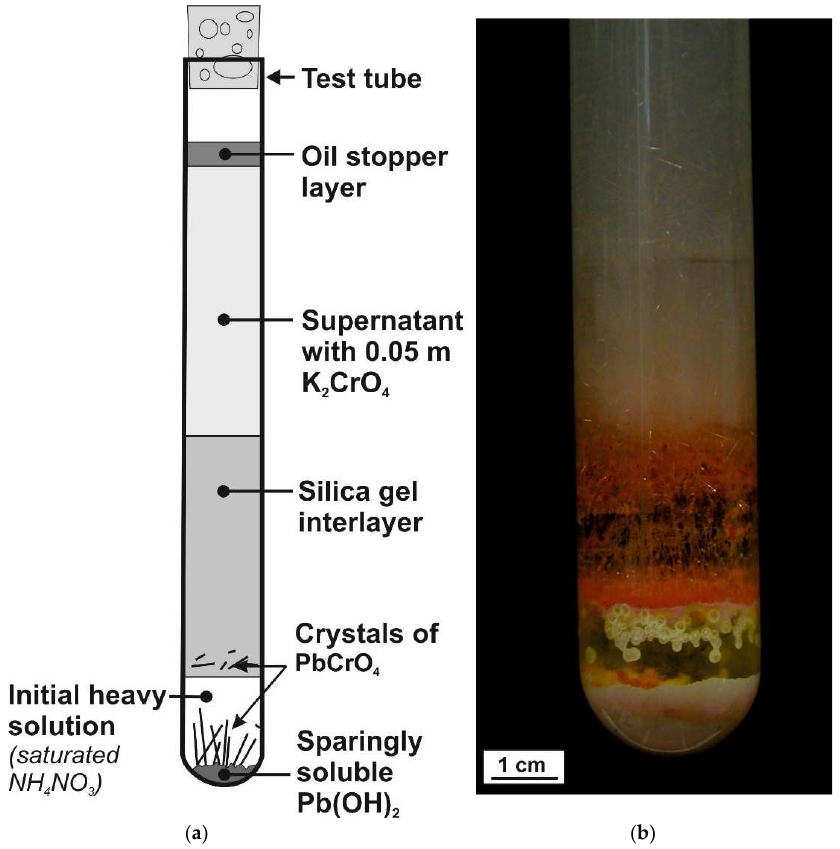
Figure 16. Hybrid gel setup to obtain PbCrO 4 (krokoite) crystals. ( a ) Schematic representation of the experiment; ( b ) Detail of the reaction alcove with the orange PbCrO 4 product. Note the white layer of the insoluble Pb(OH) 2 reagent on the bottom of the test tube. The scheme adopted above can be used for the synthesis of many other types of minerals including hydrous REE-phosphates, such as churchite-(Y), YPO 4 ∙2H 2 O, or the former and synthetically obtained hydroxylapatite, Ca 5 (PO 4 ) 3 (OH) for the latter in powdered form, acting as the respective sparingly soluble reagents. The reaction alcove was again formed directly above the powders using NH 4 NO 3 . After the placement of an HNO 3 -acidified 0.3 m Na 2 SiO 3 gelling solution and ageing of the obtained gel in both examples, a 0.3 m NaPO 3 solution was administered in the former and a 0.3 m CeCl 3 solution in the latter case. In approximately five months, beautiful multifaceted churchite- (Y) single crystals formed in the former case (Figure 17a). As for the rhabdophane setup, the whole of the synthetic hydroxylapatite reagent was converted to the respective title compound, albeit with the crystals having a somewhat fibrous form (Figure 17c). The successful use of the given configuration to obtain anglesite single crystals (Figure 17b) with Pb(OH) 2 as the near-to-insoluble reagent and 0.5 m Na 2 SO 4 as supernatant is yet another justification for the usefulness of the hybrid gel growth techniques.